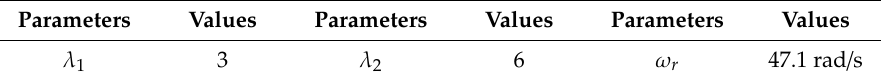
Table 11. Optimal configuration parameters of the water turbine.